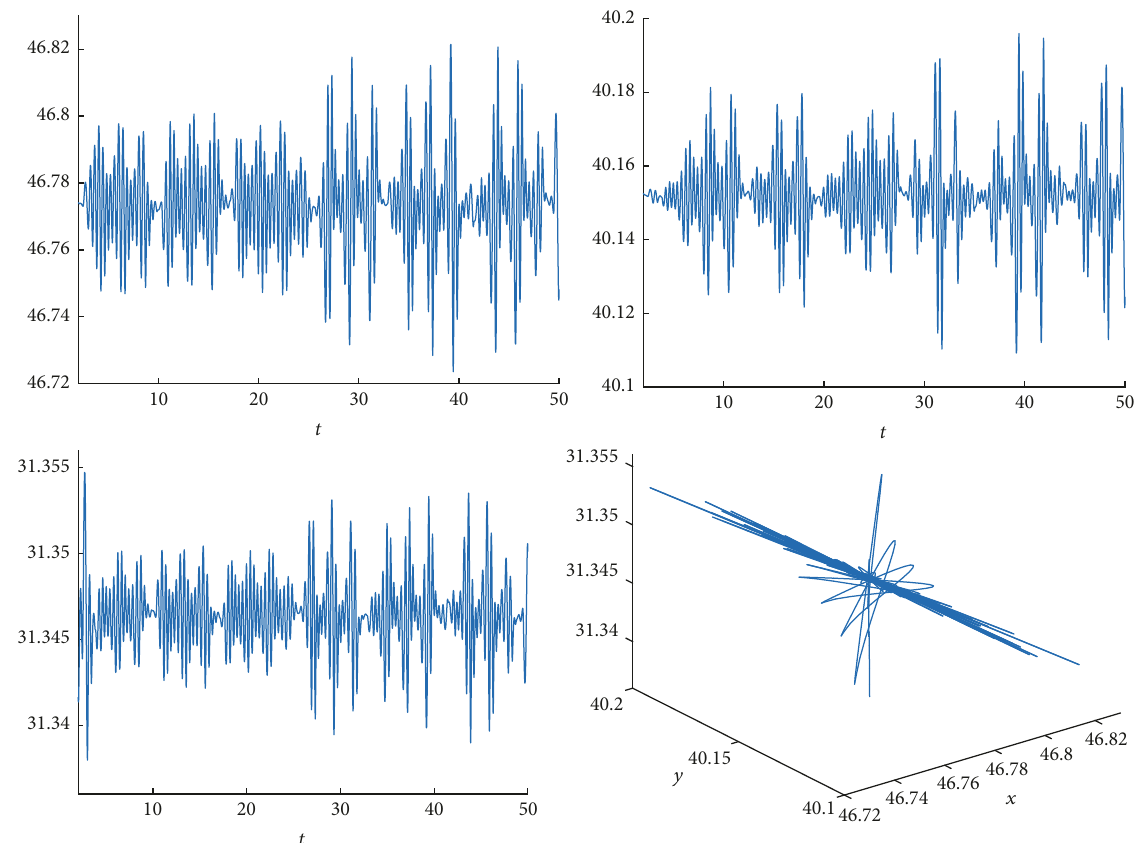
Figure 5: Dynamical behaviors and phase space trajectories of the three fish